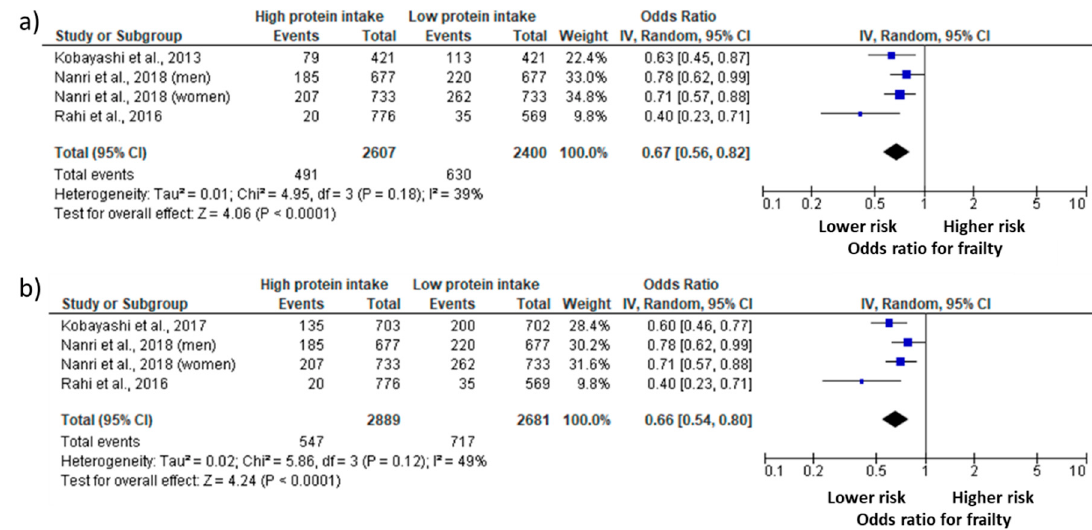
Figure 2. Odds ratio (OR) of the prevalence of frailty in older adults with high and low protein intake. Squares represent study-specific estimates; diamonds represent pooled estimates of random-effects meta-analyses. ( a ) The analysis was performed included Kobayashi et al. 2013; ( b ) The analysis was performed included Kobayashi et al. 2017.